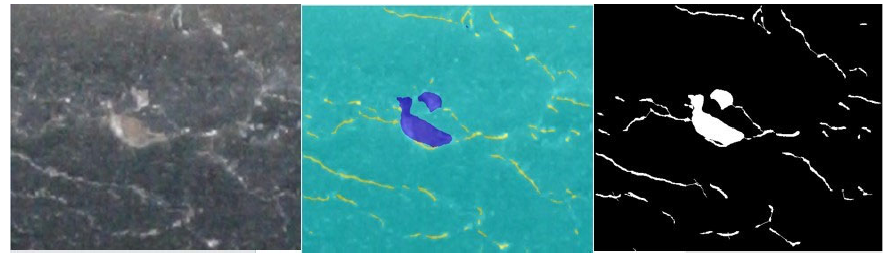
Figure 10. Cracks after connection.